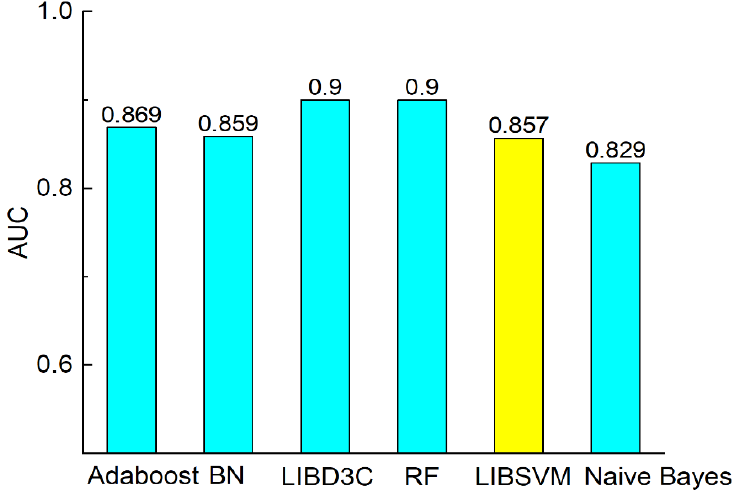
Figure 7. Comparison of AUC on different classifiers.